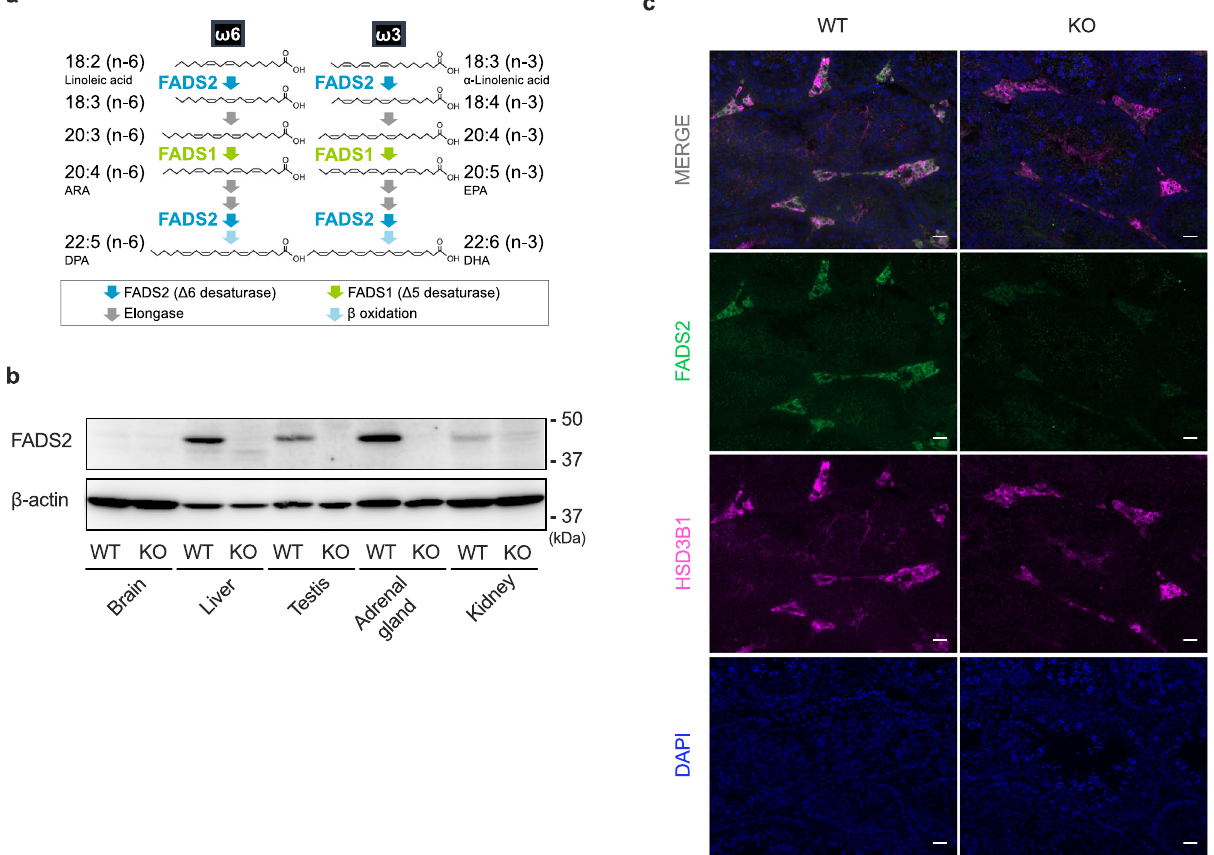
Fig. 1 FADS2 is highly expressed in Leydig cells. a The biosynthetic pathway of HUFAs. b Tissues from FADS2 + / + (WT) and FADS2 − / − (KO) mice were analyzed by immunoblotting using an anti-mouse FADS2 antibody. β -actin was used as a loading control. c Immunohistochemical analysis of testis sections from 12-week-old FADS2 + / + and FADS2 − / − mice. Green, FADS2; Magenta, HSD3B1; blue, DAPI. Scale bar, 50 µ